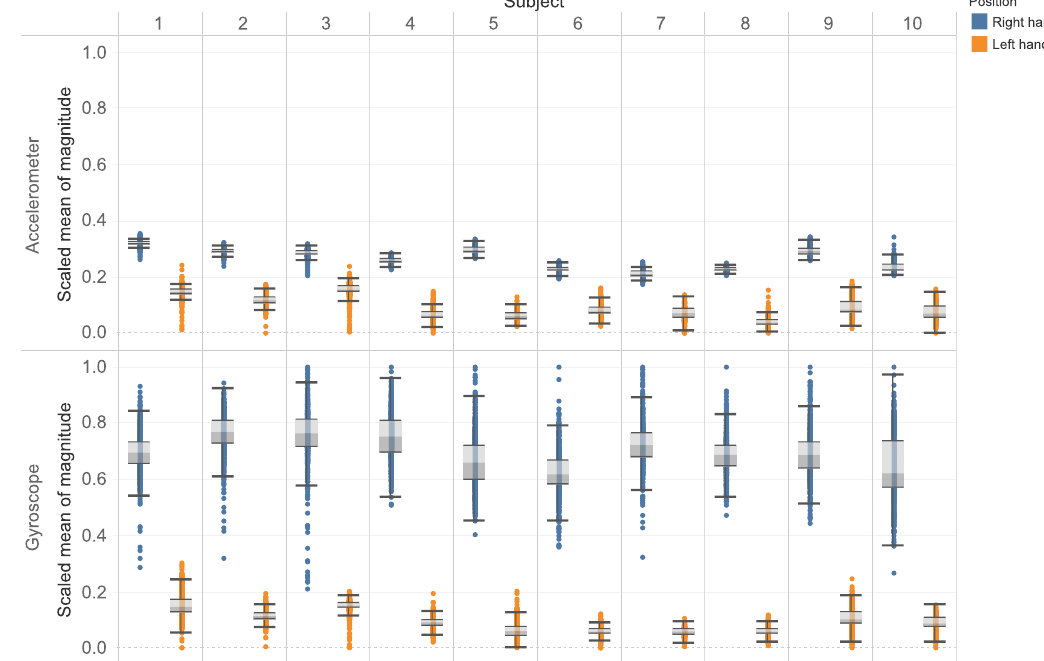
Figure 8. The boxplot for hand sides of all subject using accelerometer and